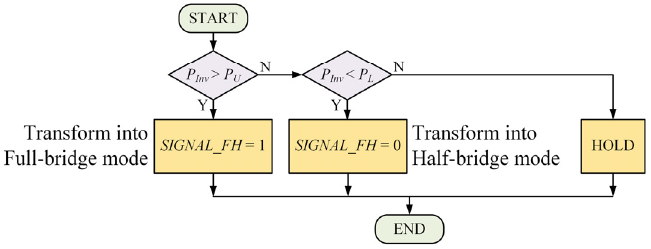
Figure 9. Hysteresis controller for the transform signal generation.